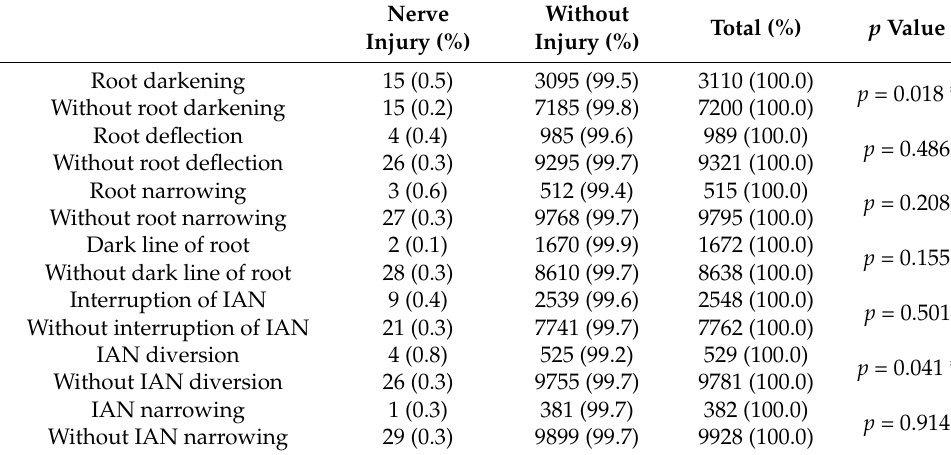
Table 14. Association between panoramic signs and inferior alveolar nerve (IAN) injury.